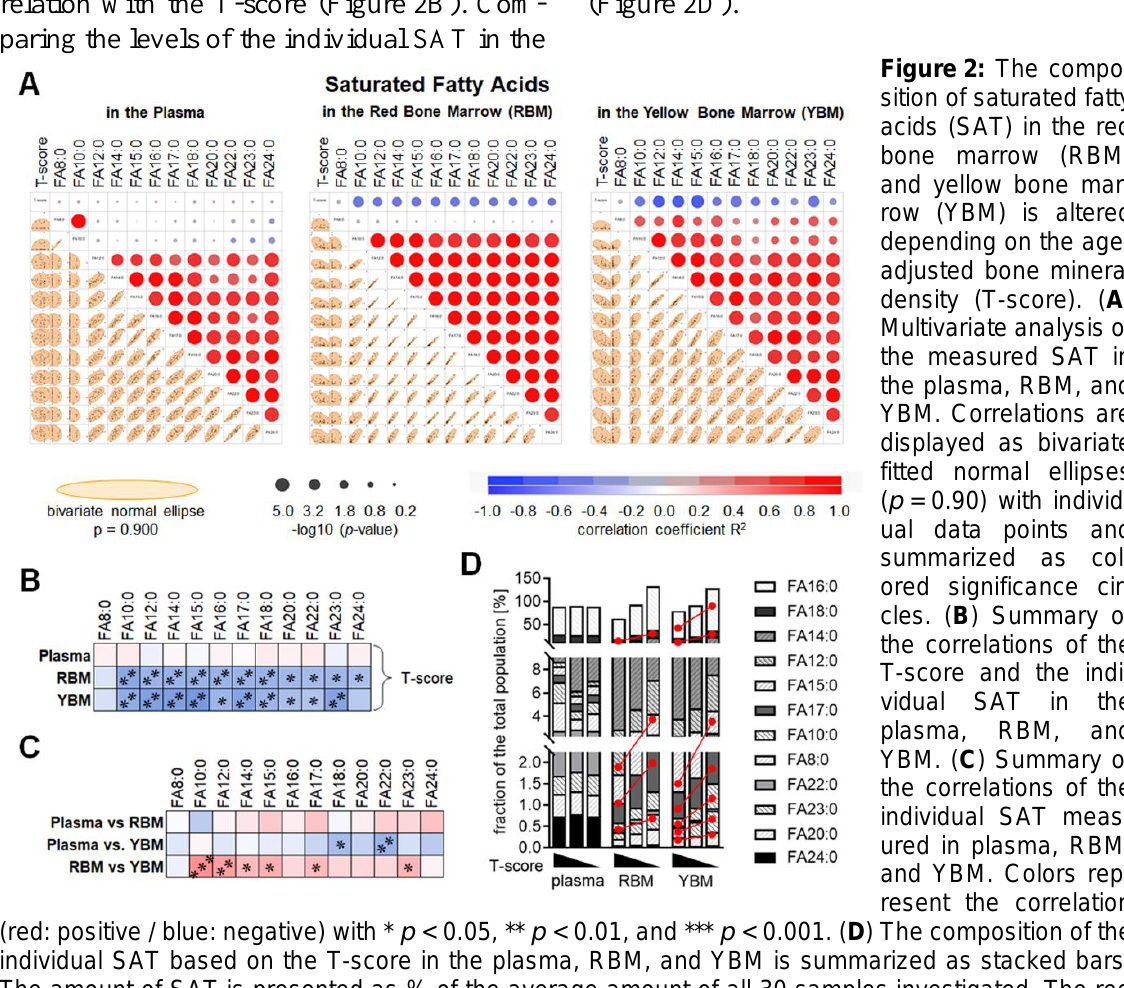
(red: positive / blue: negative) with * p < 0.05, ** p < 0.01, and *** p < 0.001. ( D ) The composition of the individual SAT based on the T-score in the plasma, RBM, and YBM is summarized as stacked bars. The amount of SAT is presented as % of the average amount of all 30 samples investigated. The red lines mark significant ( p < 0.05) changes between the three groups (normal bone mineral density / os- teopenia /